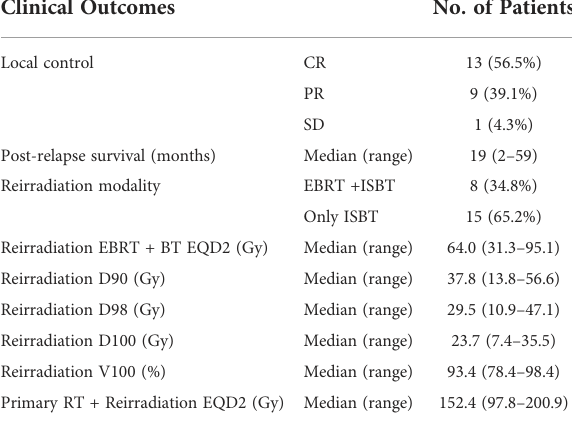
TABLE 2 Treatment outcomes of involved patients.